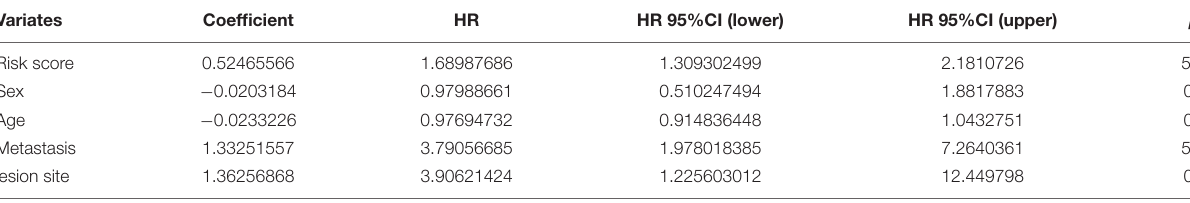
TABLE 2 | Univariate analysis of risk score and characteristics in training cohort. Variates